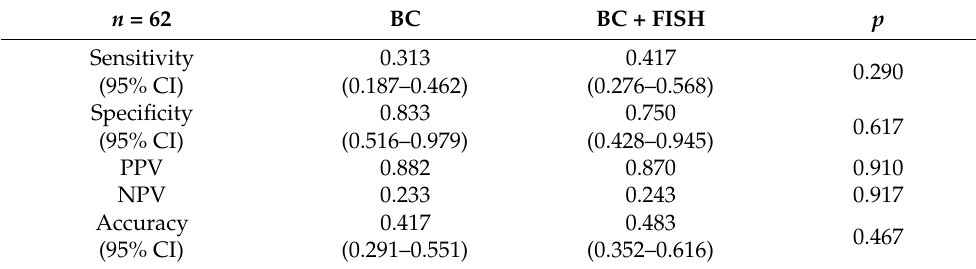
Table 5. Statistical performances of brush cytology (BC) vs. BC + FISH (extrinsic stenosis group). n = 62 BC BC + FISH p